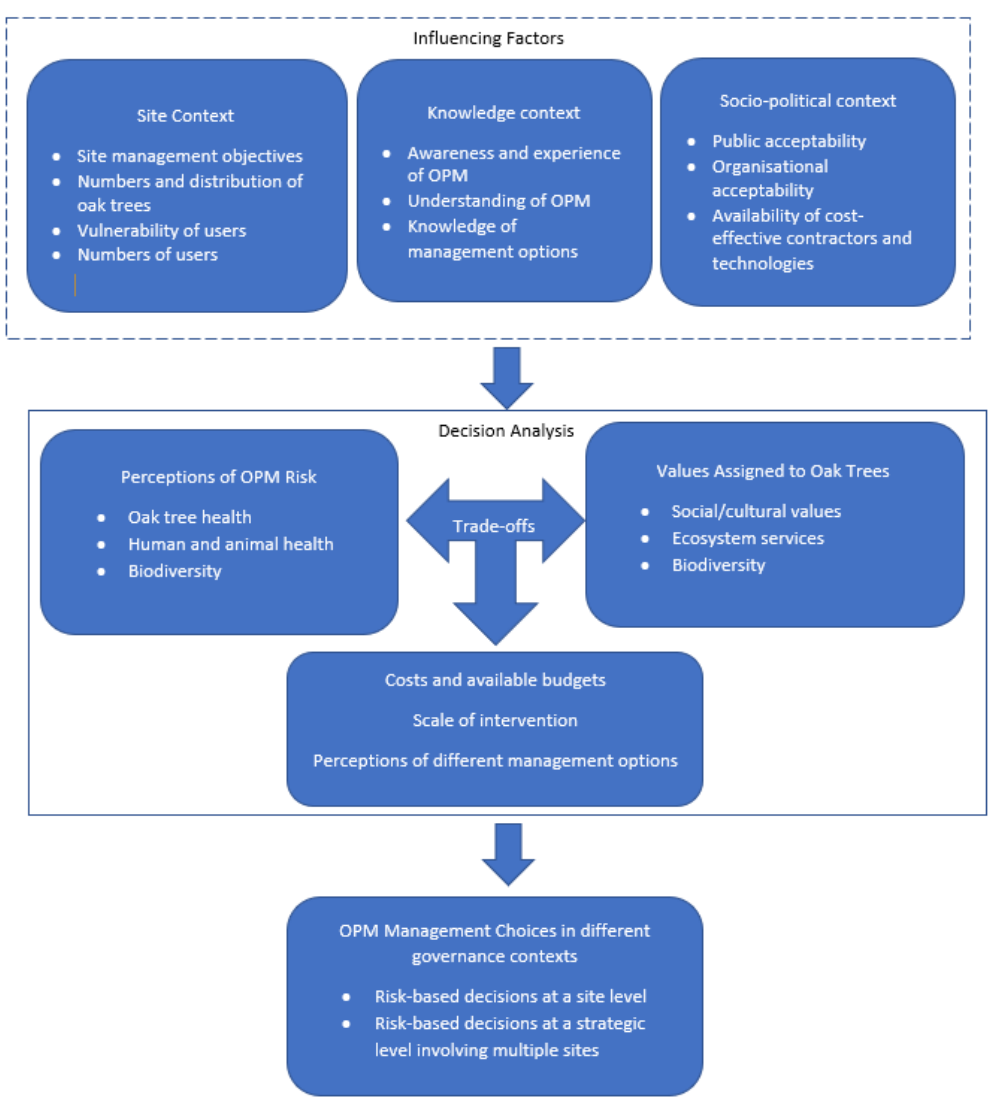
Figure 2. Conceptual Framework highlighting trade-offs between values associated with oak and perceptions of OPM risk. (a) Factors likely to influence decision-making are based around the site in question, knowledge and awareness of OPM and OPM impacts and wider socio-political contexts; (b) Influencing factors will inform assessments of risk and what is economically feasible as well as socially acceptable when considering the multiple values associated with oak trees; (c) Decisions will also be influenced by scale e.g., whether it is a single site or multiple sites of varying sizes.